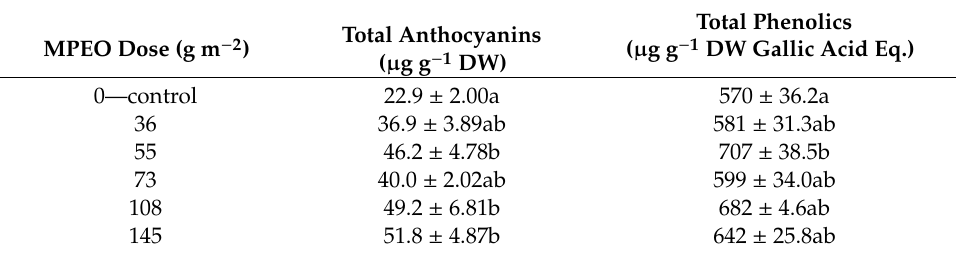
Table 4. Biochemical characteristic of aboveground parts of white mustard cv. ‘Zlata’ at the growth stage of two pairs of leaves (BBCH 14), growing in the silty clay loam soil substrate and in the presence of di ff erent doses of microencapsulated peppermint essential oil (MPEO with 9.6% (v / w) of peppermint EO